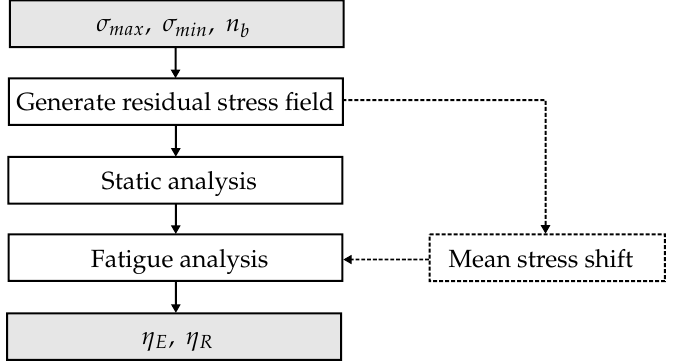
Figure 12. Extended simulation